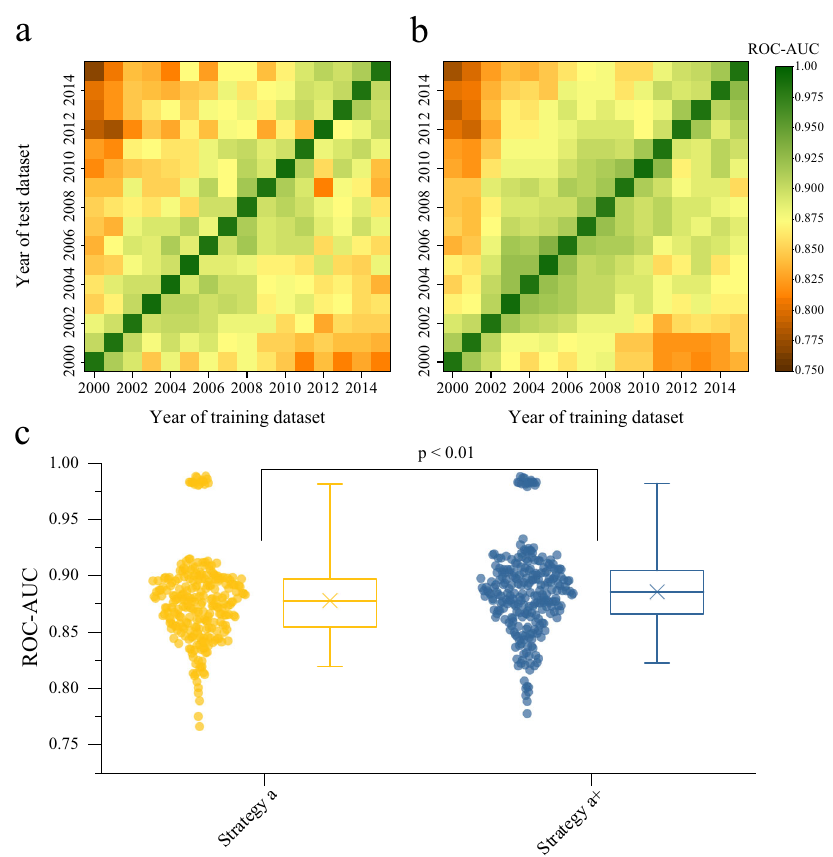
Fig. 1 Validated performance on a time scale of the boosted regression tree models. The boosted regression tree (BRT) models were trained on one-year incidence samples under strategies a ( a ) and a + ( b ). Throughout the validation process, the values of area under the receiver operator characteristic curve (ROC-AUC) range from 0.750 (Dark brown) to 1 (Green). The p value ( p = 0.0013) was determined by the two-tailed Mann – Whitney test ( n = 256), representing a comparison ( c ) between strategies a (the pairing of stable background contexts with one-year climate deviation related covariates) and a + (same as a, but with two-year climate deviations) during the validation process. For each box plot, the ‘ × ’ indicates the mean; the box indicates the upper and lower quartiles and the whiskers indicate the 5th and 95th percentiles of the